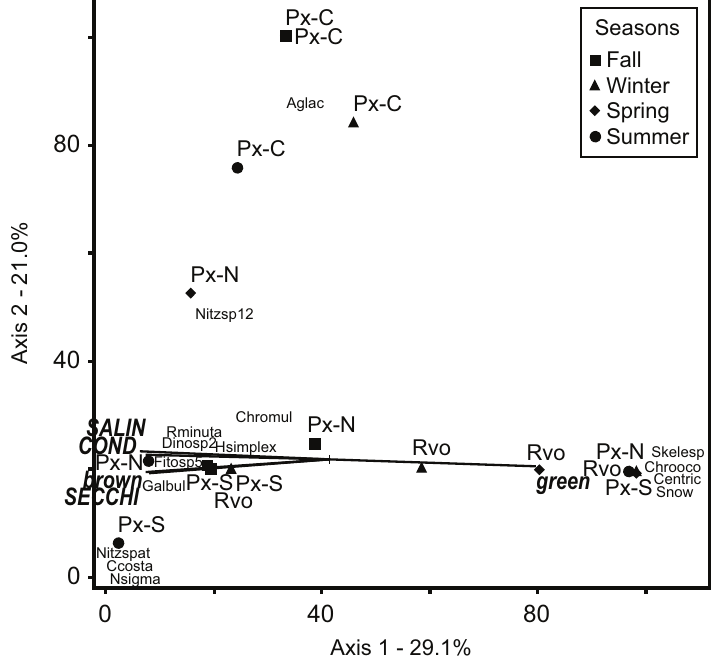
Figure 6 - Canonical Correspondence Analysis (CCA) Ordination plot for seasonal phytoplankton biomass of recorded taxa in the Ruivo and Peixe lagoons. (Legend for locations and variables see Table I; Aglac - Asterionellopsis glacialis , Nitzsp12 - Nitzschia sp. 12, Dinosp2 - Dino fl agellate sp.2, Chromul - Chromulina sp., Rminuta - Rhodomonas minuta var. nannoplanctonica , Phytosp5 - Phyto fl agellate sp.5, Hsimplex - Hemiselmis simplex , Galbul - Gymnodinium albulum , Nsigma - Nitzschia cf. sigmaformis , Ccosta - Chaetoceros cf. costatus , Nitzspat - Nitzschia spathulata , Skelesp - Skeletonema sp., Chrooco - Chroococcus spp., Centric - Centric diatom, Snow - Snowella